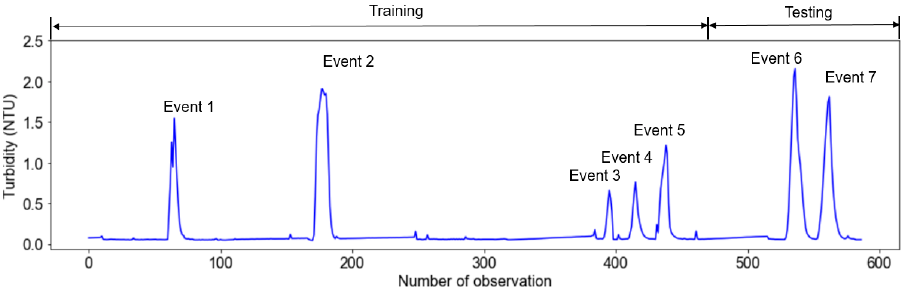
Figure 3. Turbidity observation for training and testing.